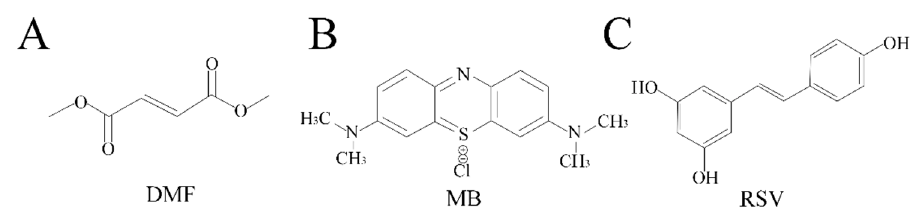
Figure 1. Chemical formula of studied compounds: ( A ) dimethyl fumarate (DMF); ( B ) methylene blue (MB); ( C ) resveratrol (RSV). blue (MB); ( C ) resveratrol